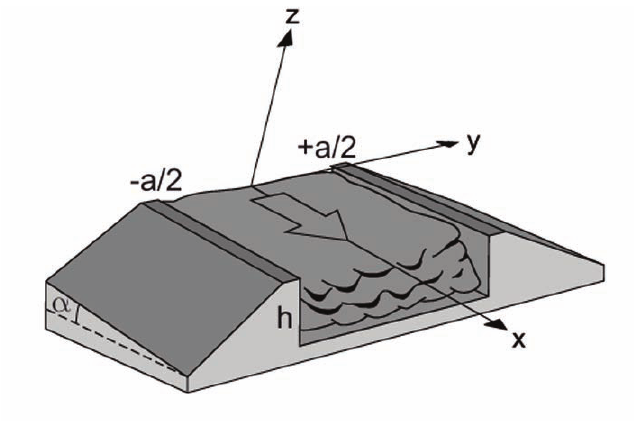
Figure 1. Coordinate system and geometrical parameters.